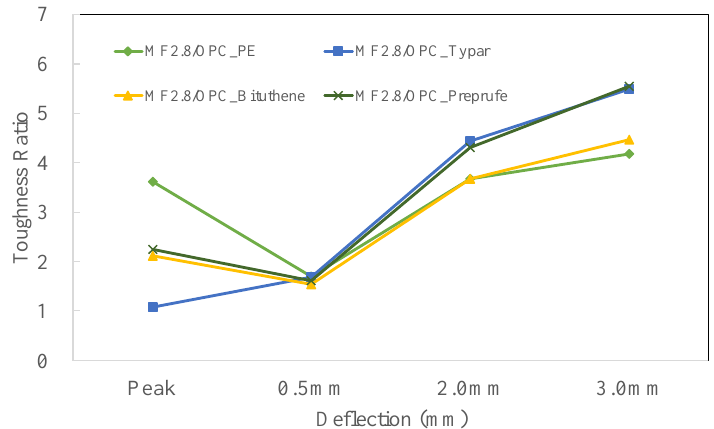
Figure 11. Toughness ratio between MF2.8 and OPC with waterproof reinforcement.